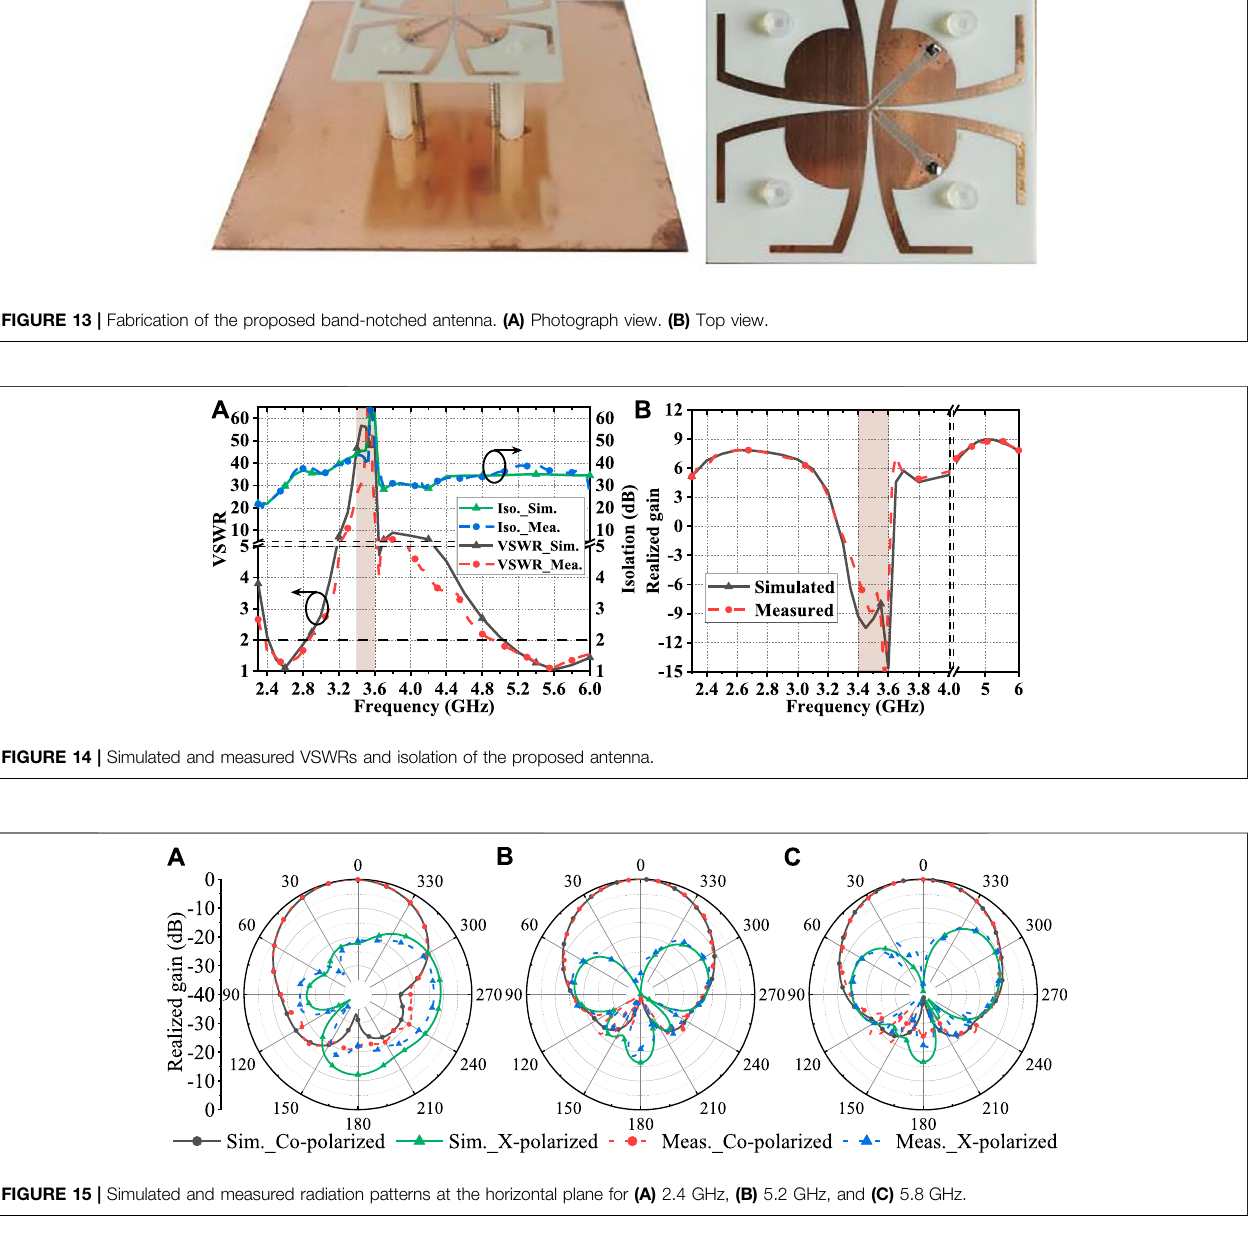
Frontiers in Physics |